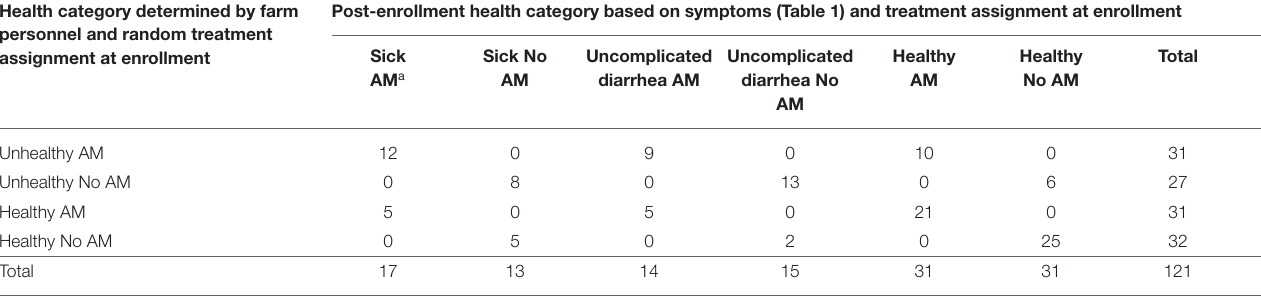
TABLE 2 | Comparison of study group allocations based on farm personnel decisions and post-enrollment criteria based on symptoms for 121 pre-weaning dairy calves. Health category determined by farm personnel and random treatment assignment at enrollment